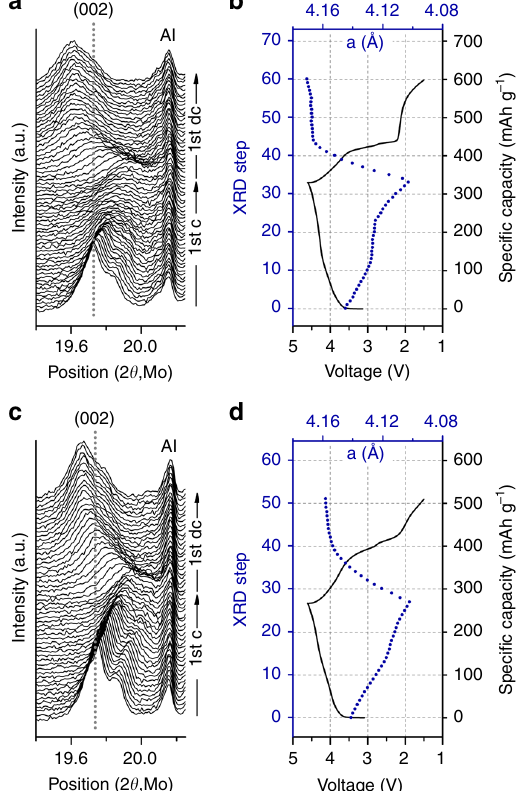
Fig. 7 Structure evolution of Li 1.2 Ni 0.333 Ti 0.333 Mo 0.133 O 2 (LN20) and Li 1.15 Ni 0.45 Ti 0.3 Mo 0.1 O 1.85 F 0.15 (LNF15) upon fi rst charge (1st c) and discharge (1st dc). a In situ X-ray diffraction (XRD) patterns, b voltage pro fi le (black line), and the lattice parameter (blue dot) of LN20. c In situ XRD patterns, d voltage pro fi le (black line), and the lattice parameter (blue dot) of LNF15. In situ XRD cells were cycled at 10 mA g – 1 at room temperature between 1.5 and 4.6